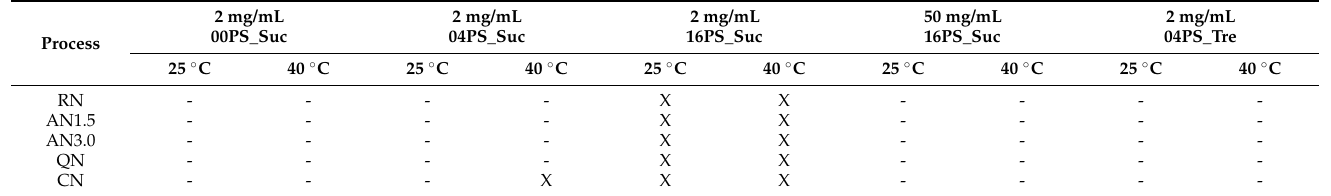
Table 7. Sample status after 12 months. X = crystallized during storage; - = still amorphous after 12